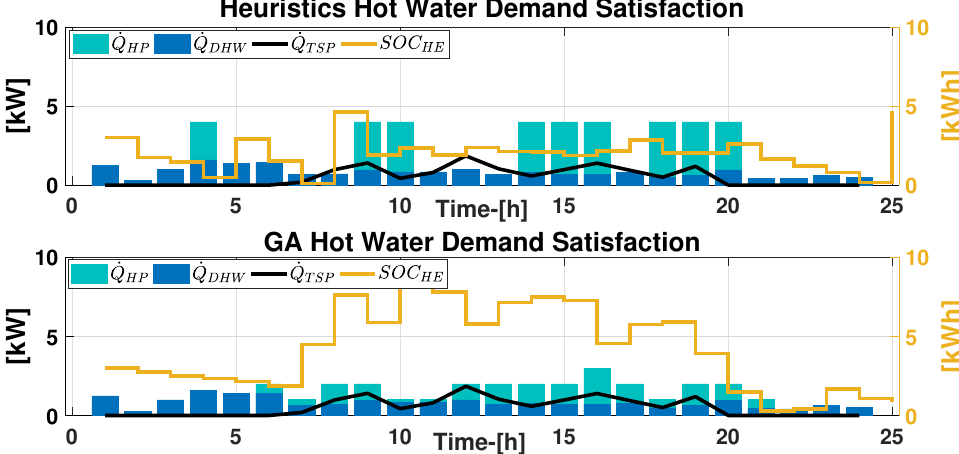
Figure 13. Heuristics and GA hot water demand satisfaction numerical